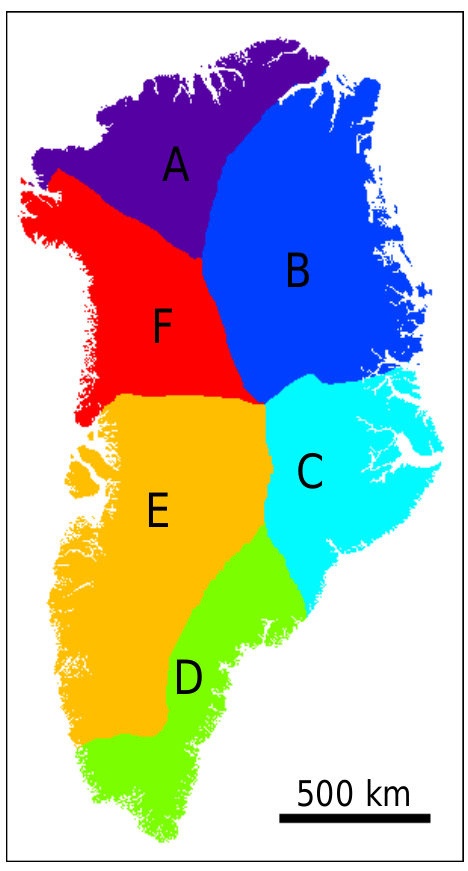
Fig. 6. The Greenland ice sheet is divided into six regions (A–F) based on groupings of drainage basins identified by Rignot et al. (2008).